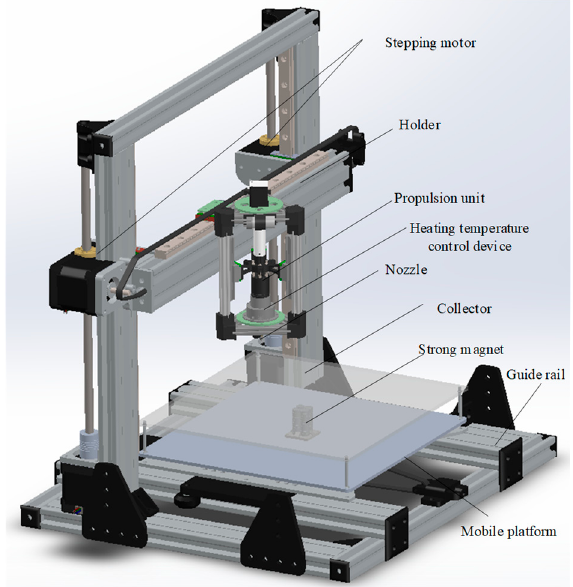
Figure 9. Magnetic spinning device.